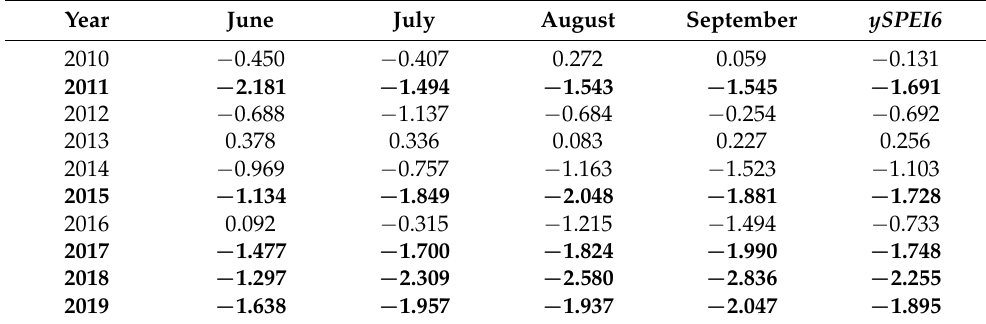
Table 1. Values of SPEI6 (Standardized Precipitation Evapotranspiration Index over six months- time scale) for each summertime month and the average of the JJAS-SPEI value of the six months- cumulated period ( ySPEI6 ) within the period 2010–2019. Drought years are reported in bold. See Vicente-Serrano et al. [29] for further details on SPEI.